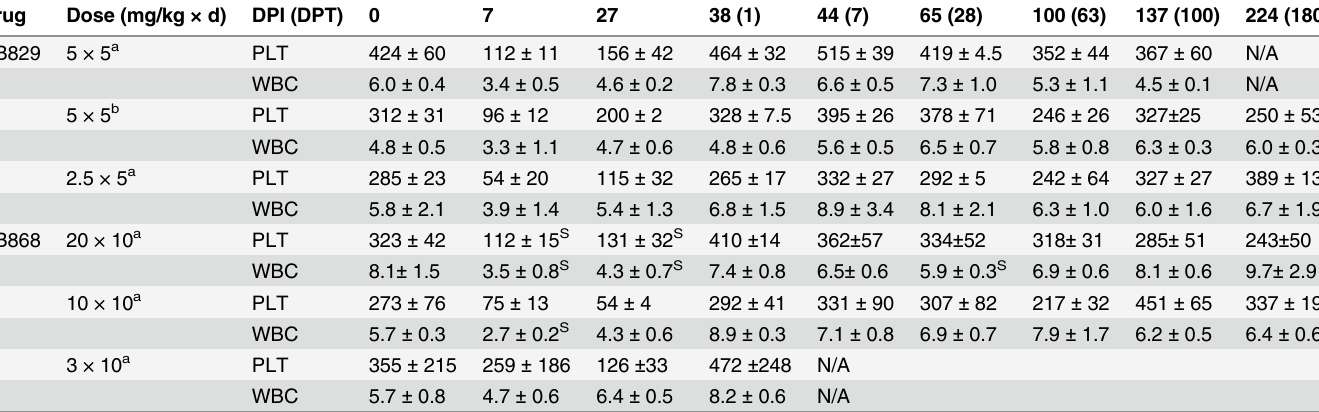
Table 4. Changes in blood platelet and white cell counts following infection of monkeys with T. b. rhodesiense and subsequent treatment within tramuscular DB829 and oral DB868. Drug Dose (mg/kg ×